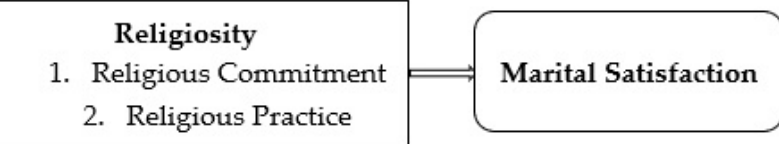
Figure 1. Conceptual Model.